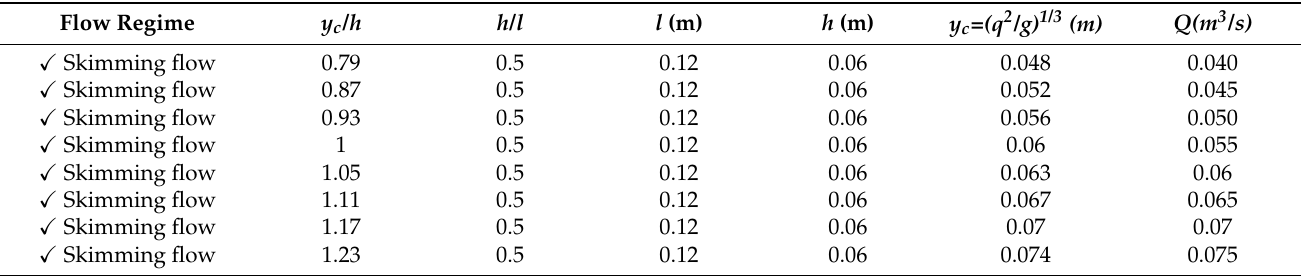
Table 1. Dimensional and hydraulic experimental and numerical parameters in the present study. Flow